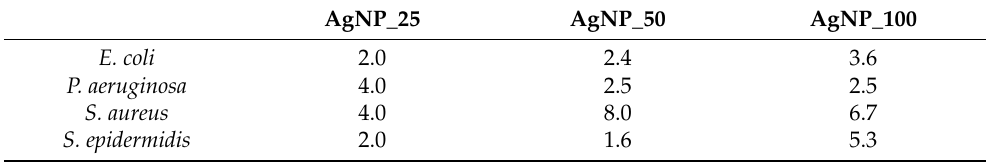
Table 4. Tolerance values of E. coli, P. aeruginosa, S. epidermidis , and S. aureus against AgNPs samples.